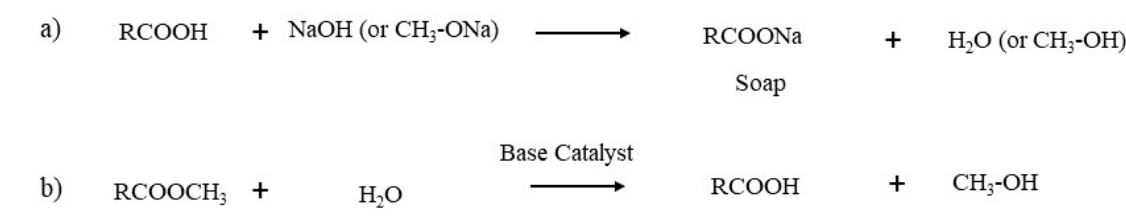
Figure 4. ( a ) Base catalyst reaction with FFAs to make soap and water, both unwanted byproducts. ( b ) Water supports the creation of FFAs. These, then, can neutralize the catalyst and generate soap, as in (a) .